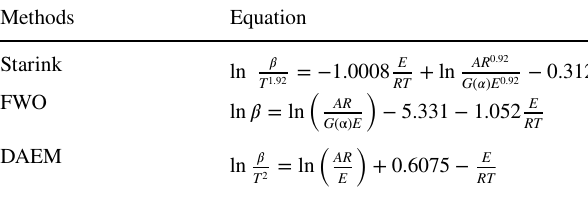
Note: β , heating rate; A , pre-exponential factor; E , activation energy; R , universal gas constant (8.314 J/mol K); T ,